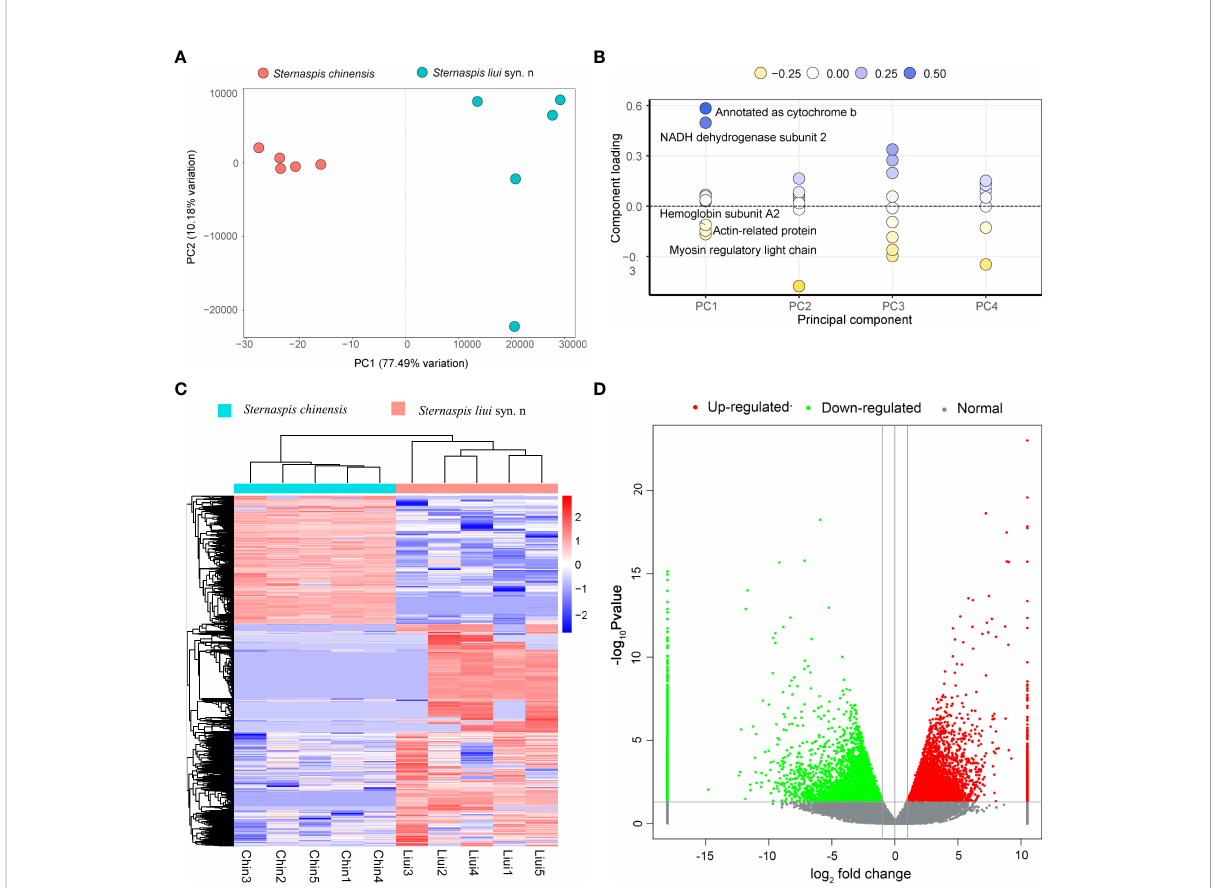
FIGURE 6 Comparative analysis of gene expression. (A) PCA for all genes. (B) Loading plot of the fi rst fi ve principal components. (C) Heatmap showing the pro fi les of the differentially expressed genes (DEGs) (red, upregulated; blue, downregulated). (D) DEG volcano plot. DEGs were fi ltered by p -value <0.05 and |log 2 fold change|